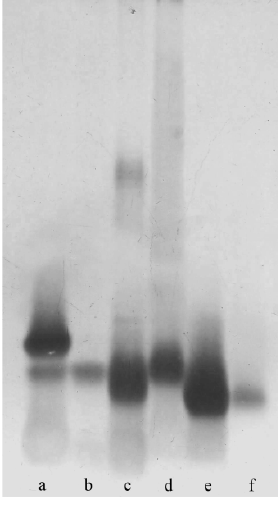
Figure 1. SDS-PAGE profiles of the lipopolysaccharides (LPS) isolated from ( a ) B. pertussis 186, ( b ) B. pertussis 606, ( c ) B. parapertussis 529, ( d ) B. holmesii ATCC 51541, ( e ) B. bronchiseptica 530, and ( f ) B. bronchiseptica 1943 .